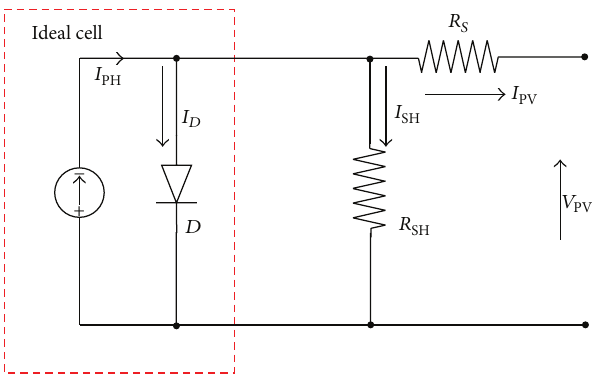
Figure 2: One-diode model of a photovoltaic cell.